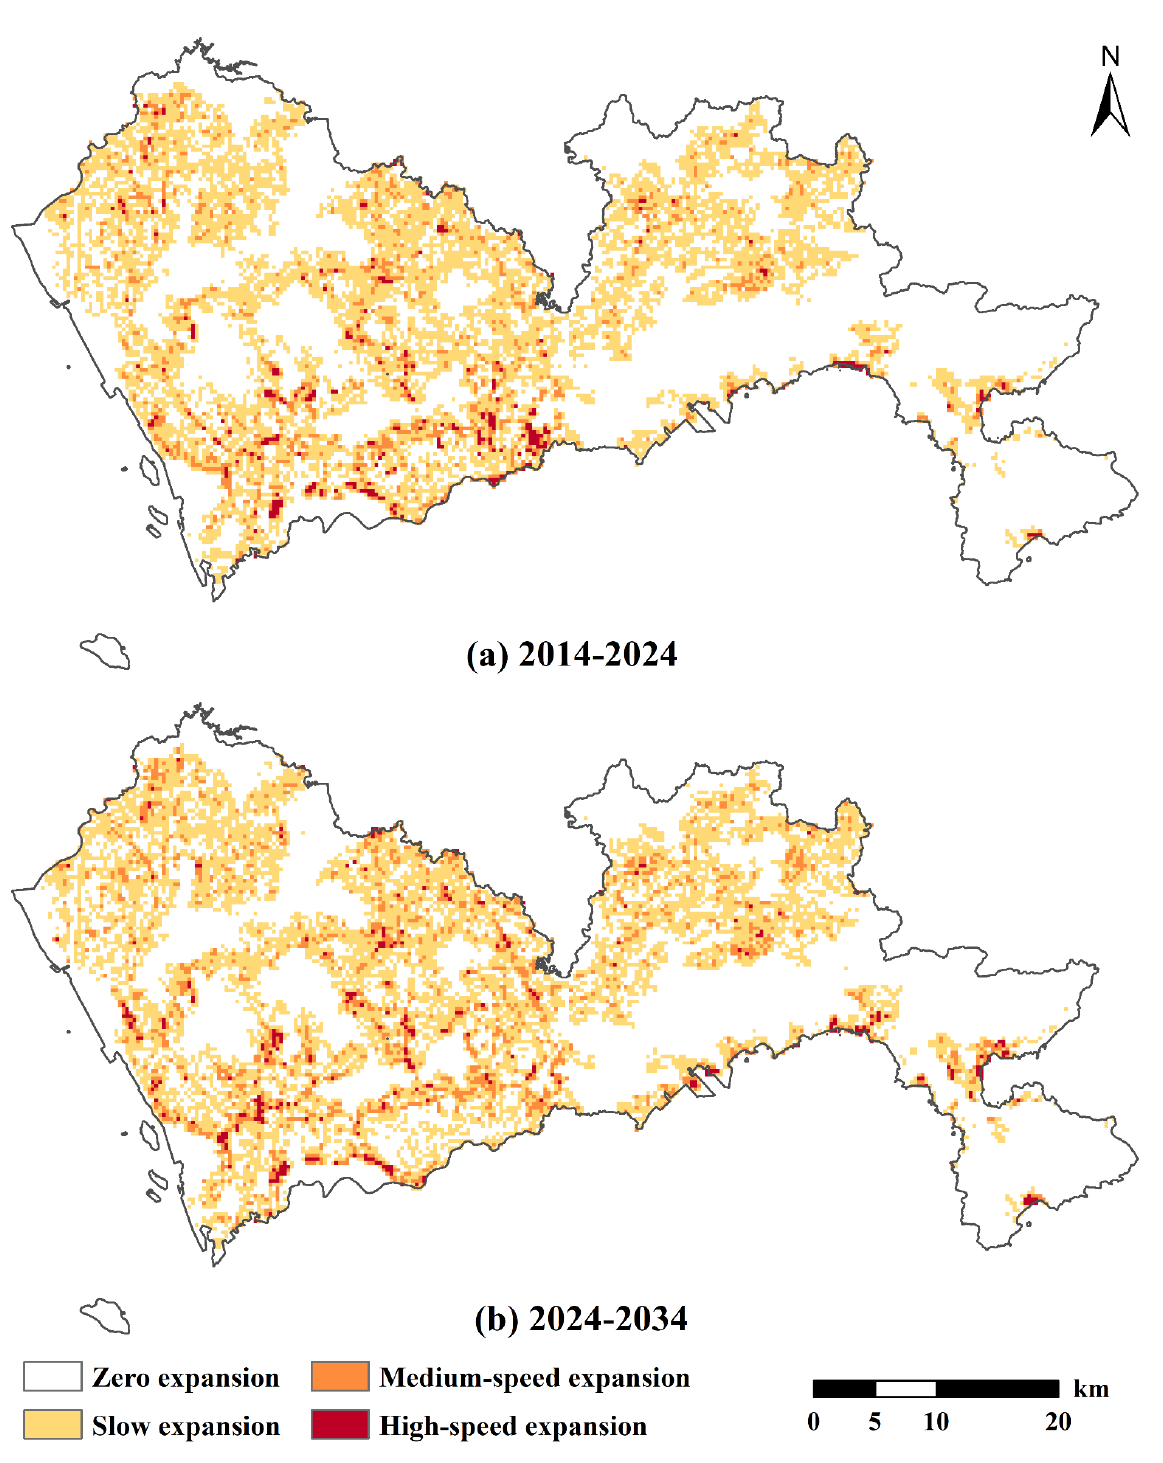
Figure 13. ( a ) The spatial distribution of urban 3D expansion intensity in Shenzhen from 2014 to 2024; ( b ) The spatial distribution of urban 3D expansion intensity in Shenzhen from 2024 to